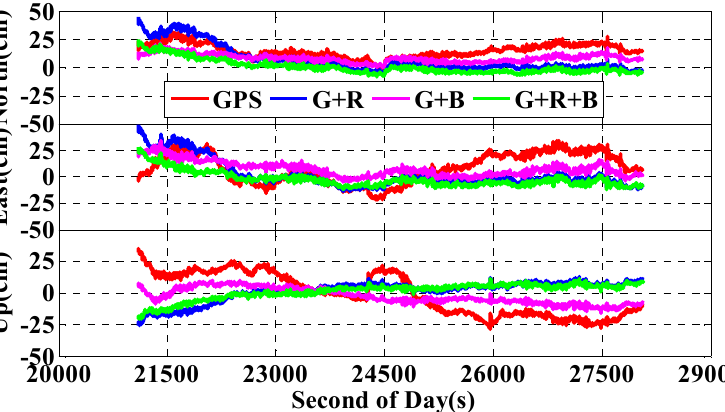
Figure 8. Position offsets time series in navigation frame (North-East-Up) calculated by making differences between the references and the solutions of the Kalman filter based PPP/INS tightly coupled integration using the single- (GPS) and the multi-GNSS (G + R, G + B, and G + R + B) data. Table 3. Improvements of the GNSS PPP/INS tightly coupled integration using GPS, G + R, G + B, and G + R + B data by comparing with the corresponding PPP solutions.